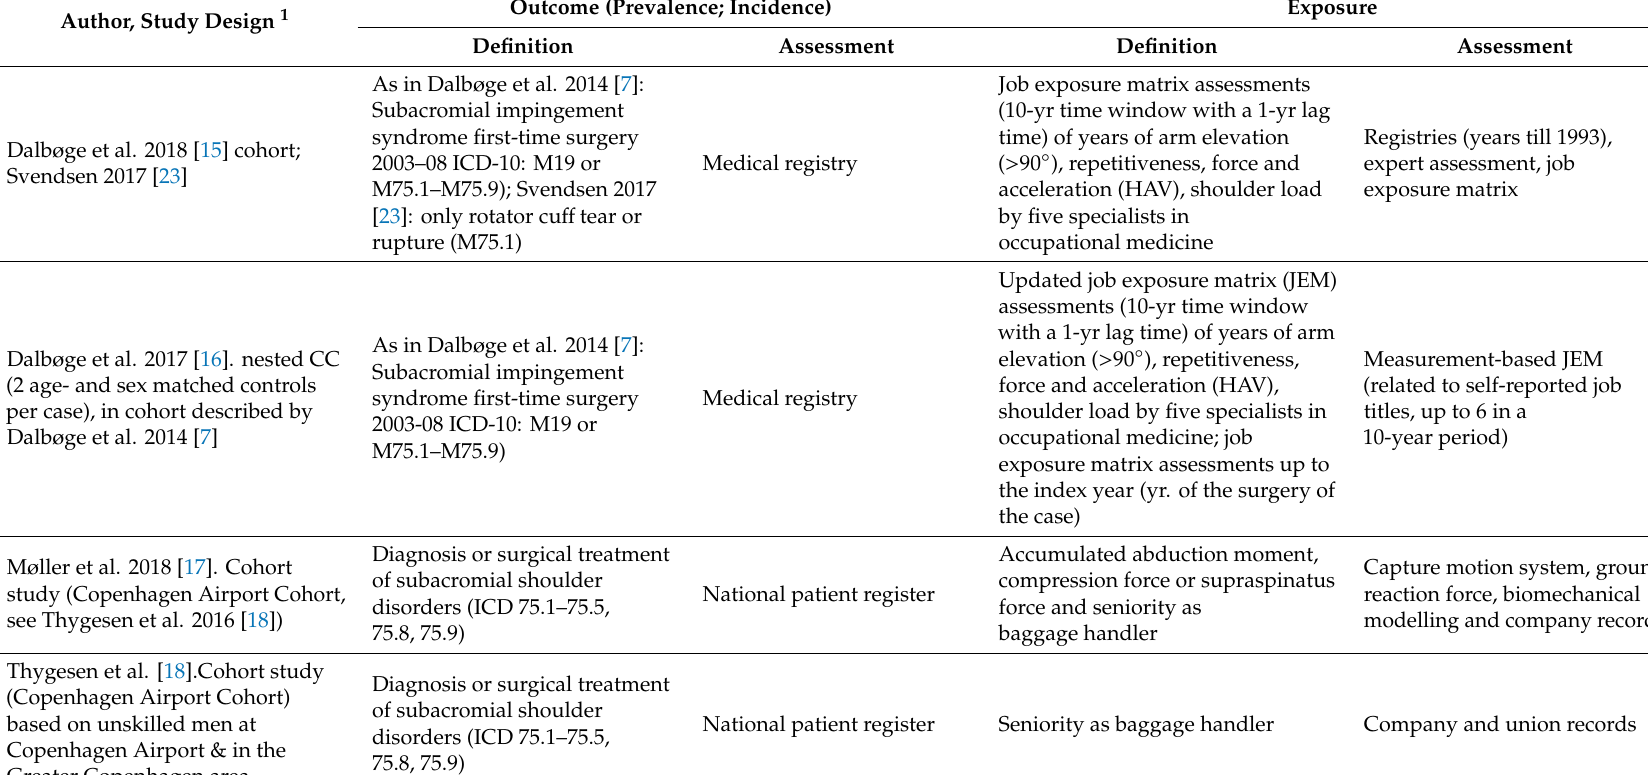
Table 1. Definition and assessment of exposure and outcomes for studies included (only publications not mentioned by van der Molen et al.